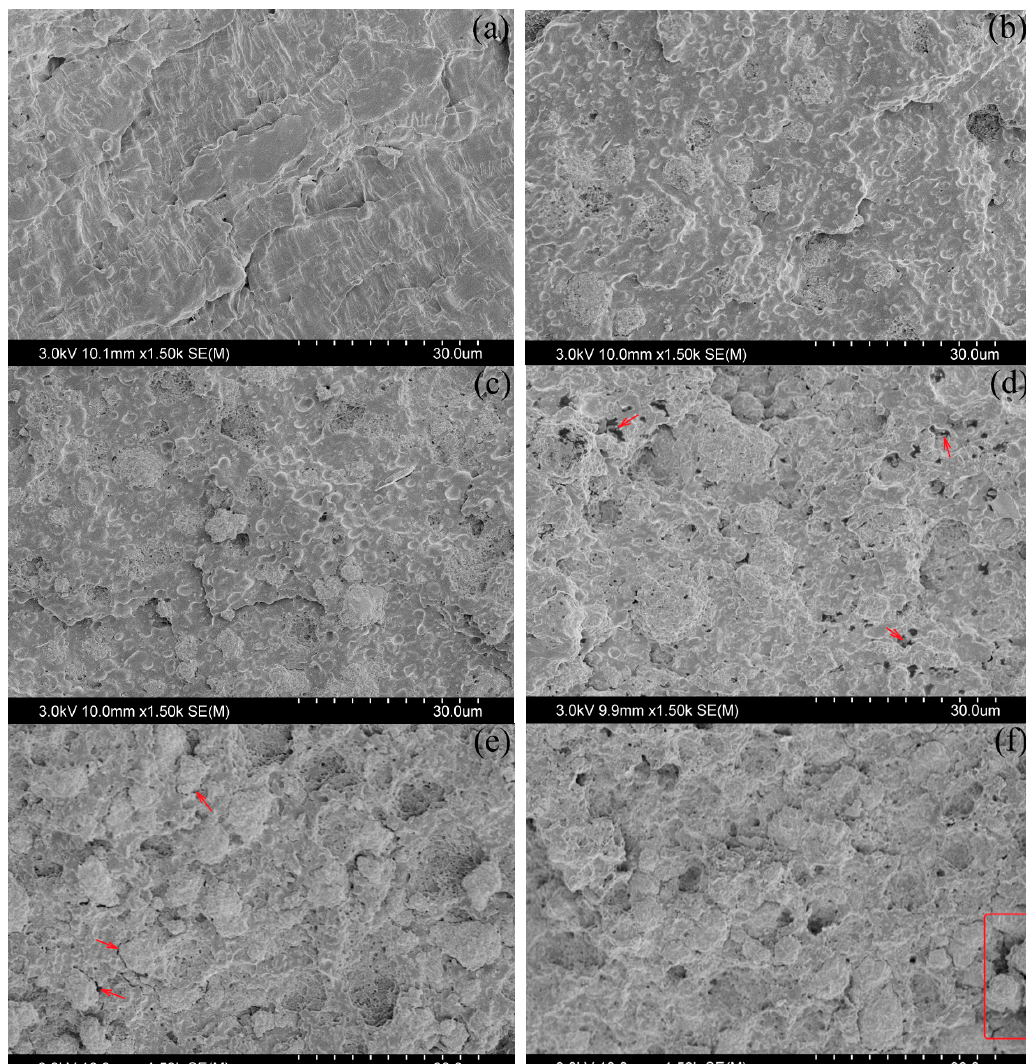
Figure 4. SEM images of fracture surfaces of PP composites with different CaCO 3 contents: ( a ) 0 wt %, ( b ) 15 wt %, ( c ) 30 wt %, ( d ) 50 wt %, ( e ) 60 wt %, ( f ) 70 wt %.